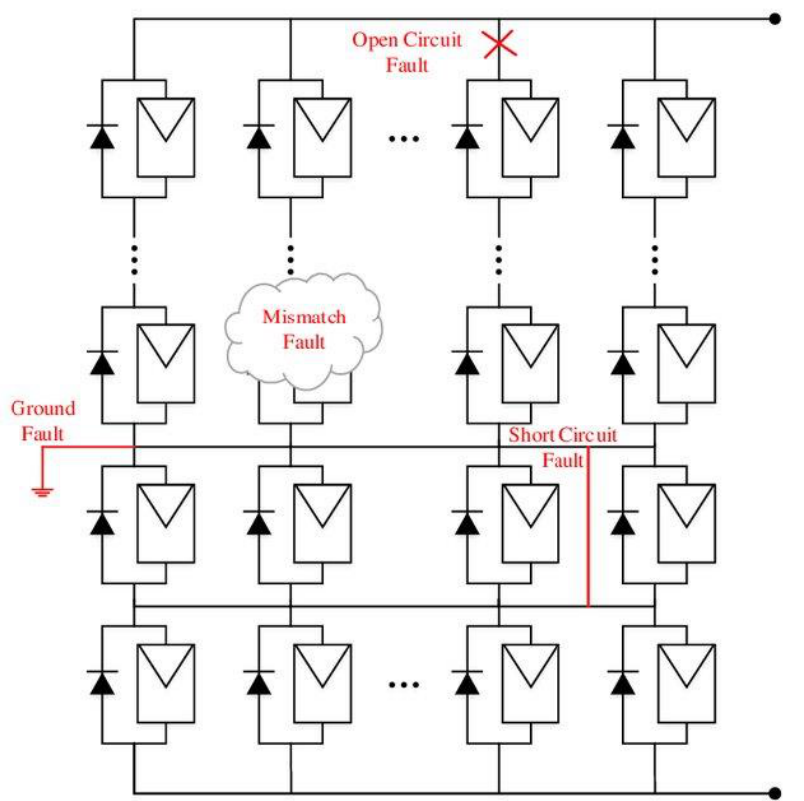
Figure 3. Faults in PV panel array [13].